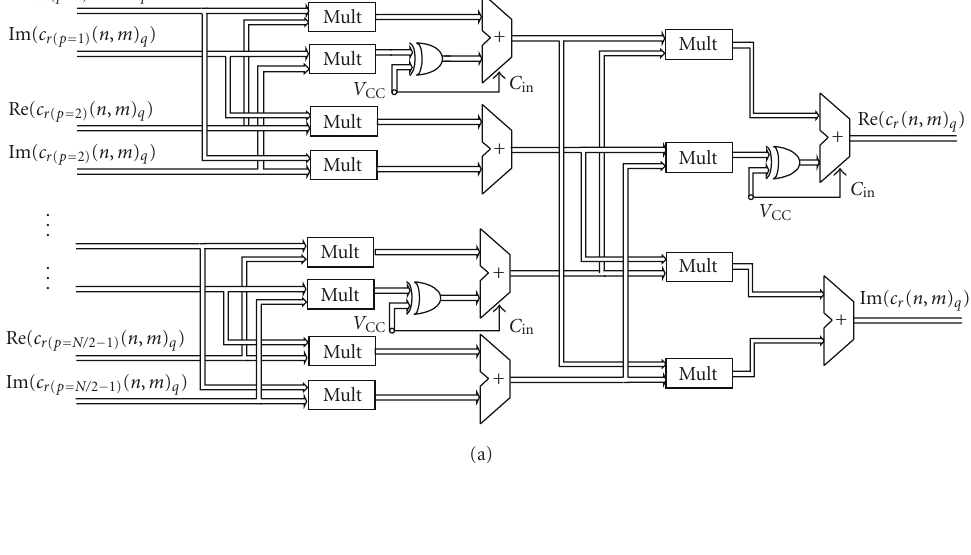
( n , m ) and c i ( n , m ) . q q p p